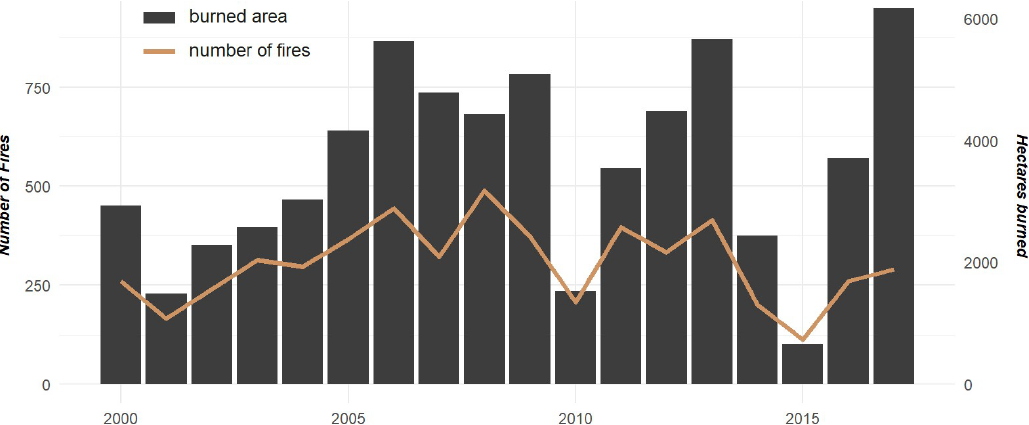
Figure 6. The number of fires and the area burned annually in the MAB from 2000 to 2017.